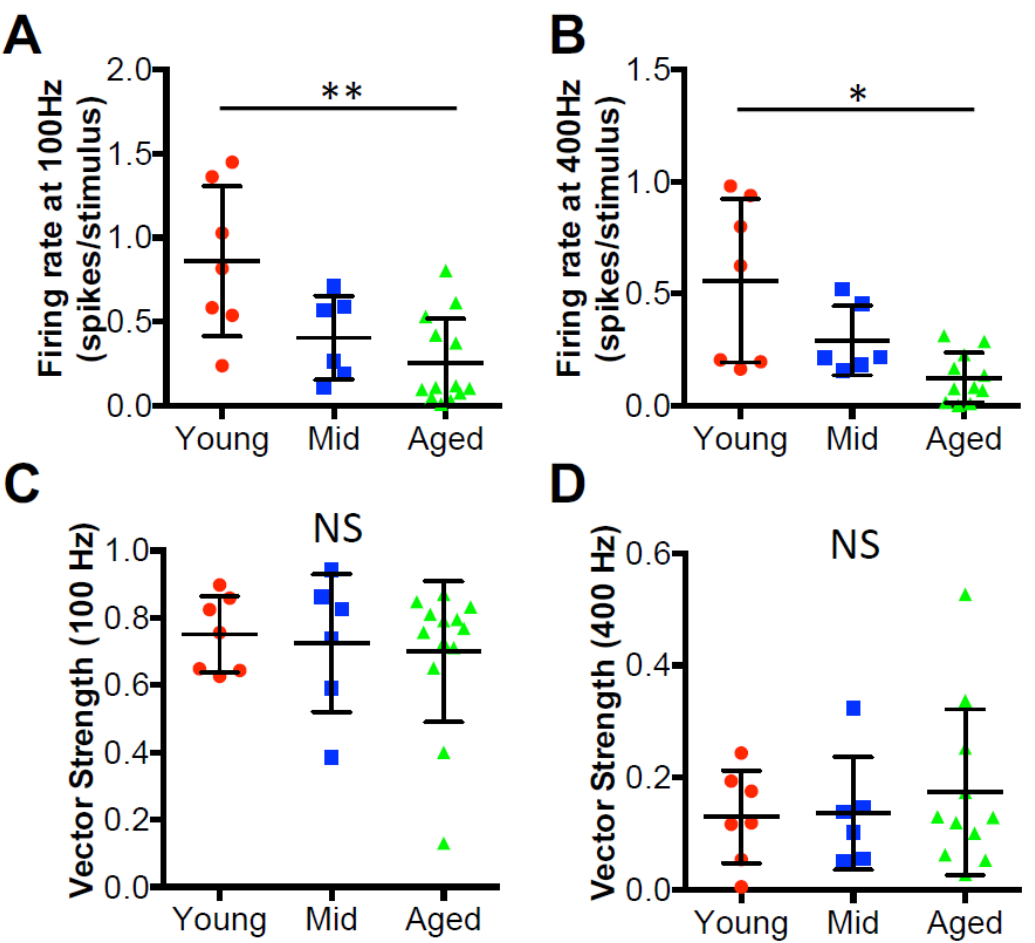
Figure 4. D-stellate neurons show decreased firing rate with age but no change in temporal coding. ( A ) Firing rates in all D-stellate neurons to 100 Hz stimulus trains at the auditory nerve. ( B ) Firing rates in all D-stellate neurons to 400 Hz stimulus trains at the auditory nerve. ( C ) Calculated vector strength of D-stellate spikes evoked by 100 Hz stimulus trains at the auditory nerve. ( D ) Calculated vector strength of D-stellate spikes evoked by 400 Hz stimulus trains at the auditory nerve. Kruskal– Wallis test (non-parametric one-way ANOVA): ** p < 0.01; * p < 0.05; NS: p >